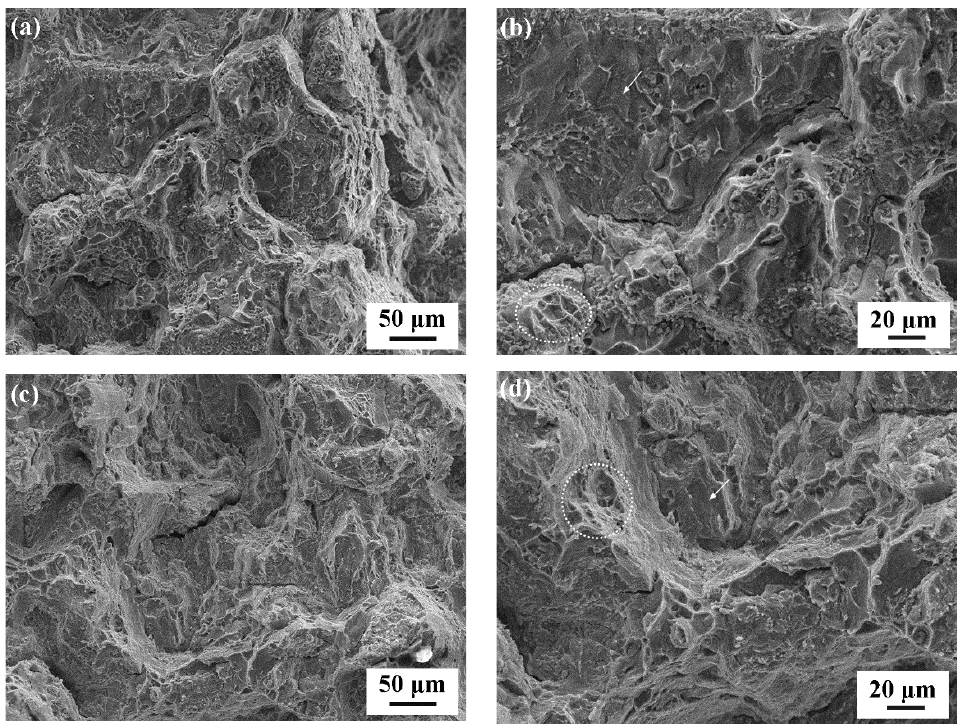
Figure 7. SEM micrographs of the tensile fracture for 7075 aluminium alloy produced by semi-solid compression at: ( a , b ) 620 °C; ( c , d ) 630